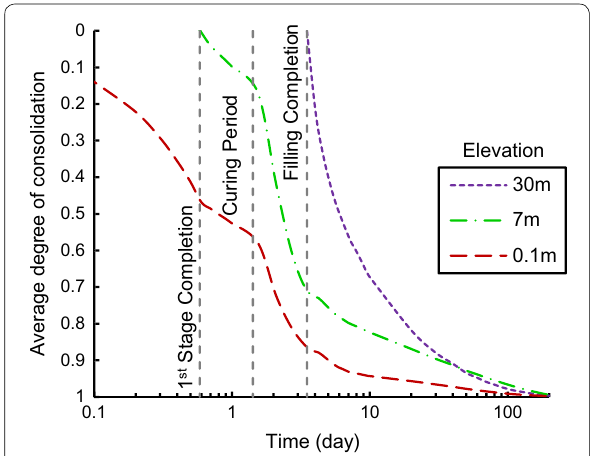
Fig. 11 Variation of average degree of consolidation with curing